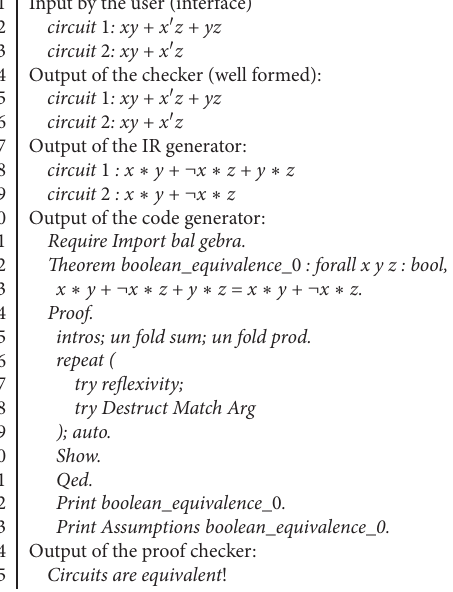
Figure 13: CoCEC equivalence checking example.